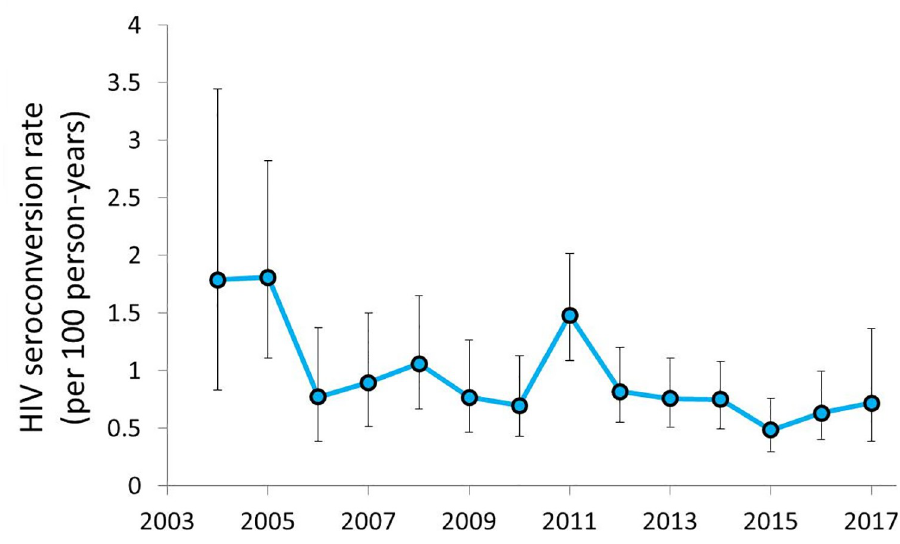
Fig 1. Annual HIV seroconversion rates among gay and bisexual men who have sex with men in British Columbia, 2003–2017. https://doi.org/10.1371/journal.pone.0261705.g001 median number of tests. Further descriptive statistics for the early and late periods are shown in Table 2. Unadjusted incidence rates per 100 person-years are presented in Table 3. Rates were higher for patients: 15–19 years of age (IR: 5.26, 95% CI: 1.92–10.96); with 5 to 14 (IR: 1.33,